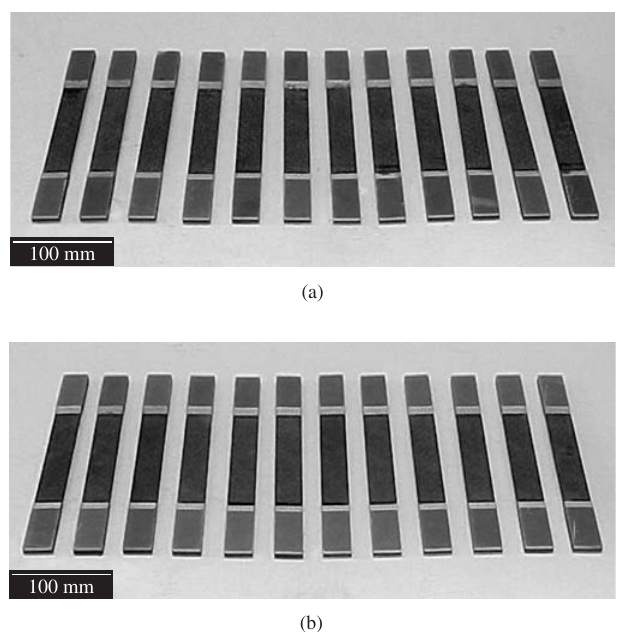
Figure 1. Specimens of laminates for tensile tests: a) F155/8HS; and b) F584/8HS